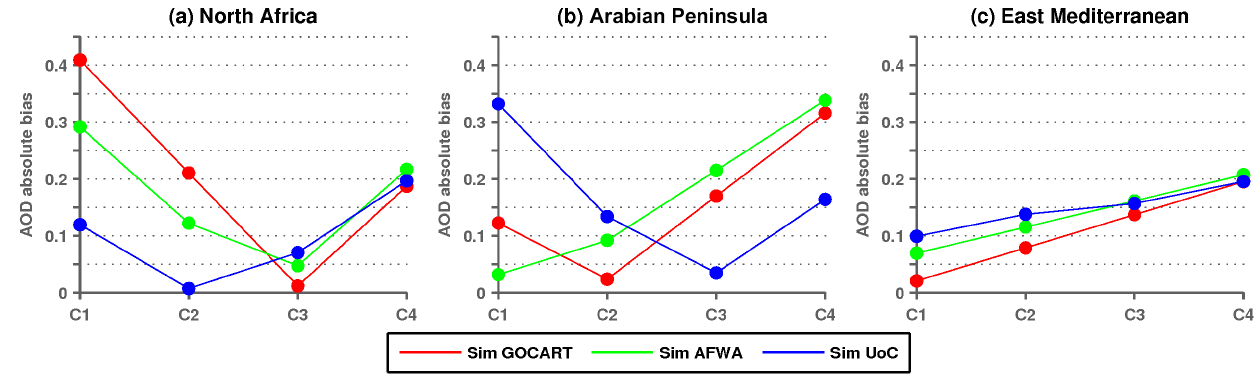
Figure 5. Average absolute bias between the simulations and MODIS observations for the whole 6-month period and for the three sub- domains, depicted in Fig. 1. The x axis values of C1, C2, C3 and C4 correspond to the coefficients applied for each simulation set. C1 equals 1, 1 and 2 for Sims_GOCART, Sims_AFWA and Sims_UoC, respectively. C2 equals 0.75, 0.75 and 1.5; C3 equals 0.5, 0.5 and 1; and C4 equals 0.25, 0.25 and 0.5.